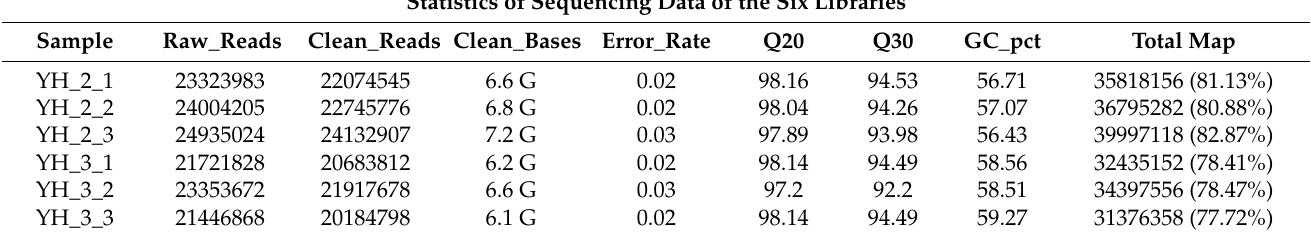
Table 1. Statistics of sequencing data of all libraries. Statistics of Sequencing Data of the Six